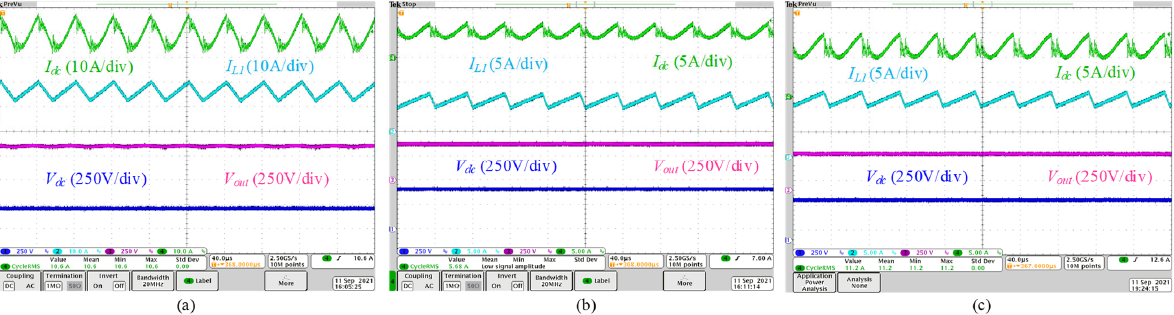
I , V OUT , and V dc from top to bot- , V OUT , and V dc from top to 1 L 1